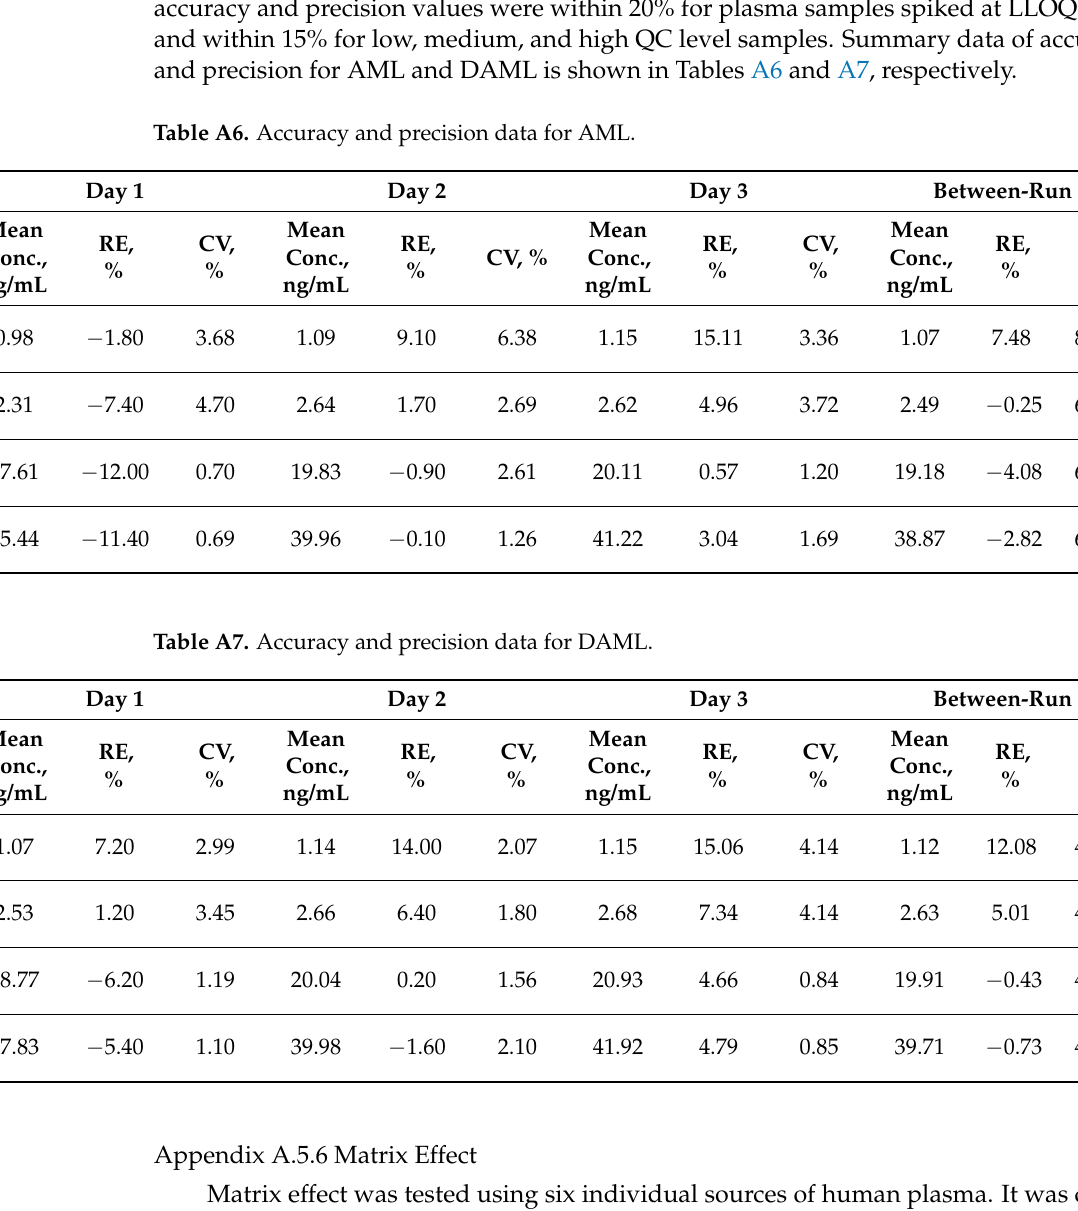
cating an insignificant “positive” matrix effect. The coefficient of variation for matrix factor determined from six human plasma sources was less than 7% indicating small variation between tested human plasma sources (see Table